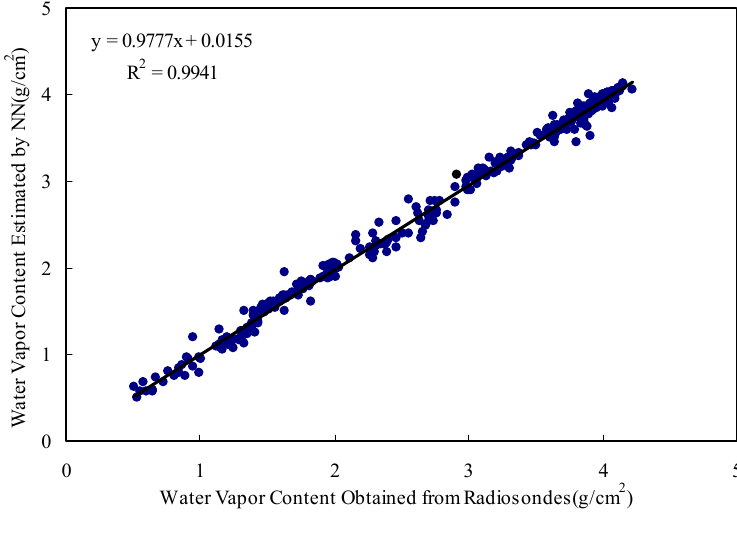
Figure 14. Validation results.